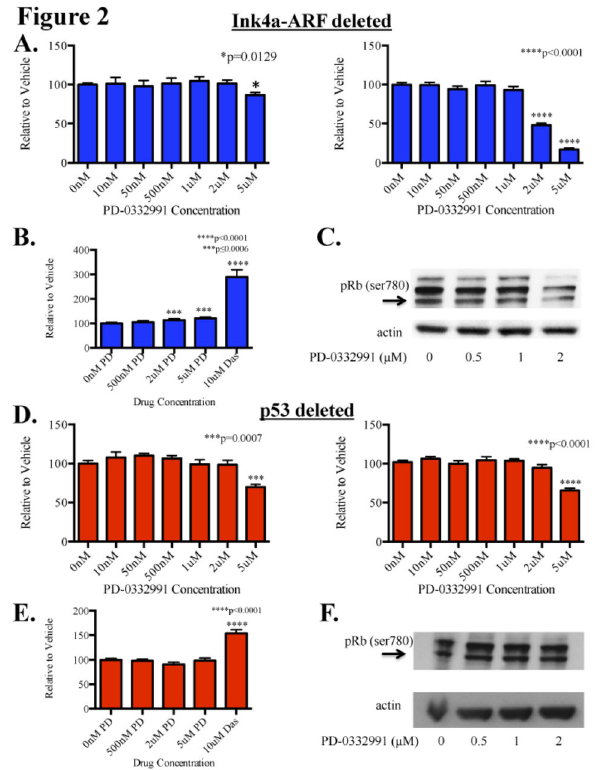
Figure 2. Effects of PD-0332991 on BSG cell lines derived from genetically engineered mouse models. Cells were treated with PD-0332991 for 48 hours before being harvested for MTT or BrdU assays to assess cell survival and proliferation, respectively. (A) MTT assays (left panel) show minimal cytotoxic activity at doses up to 5µM in cell lines derived from PDGF-B; Ink4a-ARF deficient BSGs. BrdU assays (right panel) showed inhibition of proliferation with an IC50 of 1.8µM. Assays performed in two independent cell lines. (B) Apoptosis assays showed a very small but significant increase in apoptosis at 2µM and 5µM (p=0.0006 and p=0.0002, respectively). (C) Western blot analysis shows inhibition of Rb phosphorylation at the protein level, with inhibition observed at 2µM in the PDGF-B; Ink4a-ARF deficient line after only 24 hours of treatment. (D) MTT assays (left panel) show the minimal cytotoxic activity only at doses of 5µM in cell lines derived from PDGF-B; p53 deficient BSGs. BrdU assays (right panel) showed significant inhibition of proliferation at 5µM but IC50 was not reached. (E) Apoptosis assays did not show any difference in apoptosis between vehicle and up to 5µM PD. Assays performed in two independent cell lines. Error bars represent SEM from three independent experiments. Statistical significance was determined using One-way ANOVA; paired student’s t-test was used to compare within groups. (F) PDGF- B; p53 deficient BSG cells show no decrease in pRb at doses up to 2µM even after 48 hours of treatment with